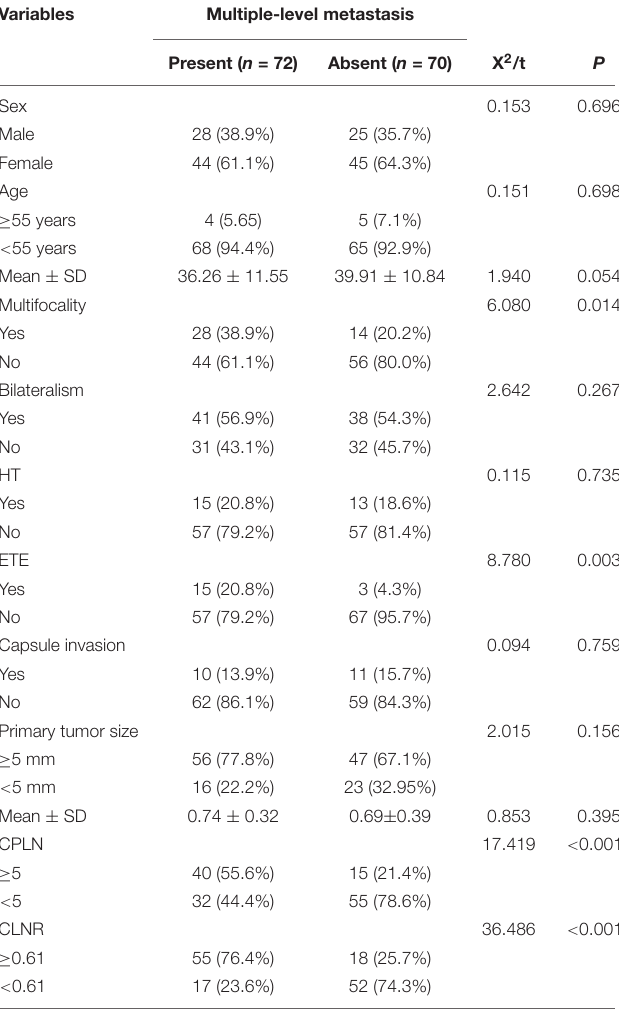
TABLE 2 | Univariate analysis of risk factors of lateral multiple-level metastasis in PTMC patients.